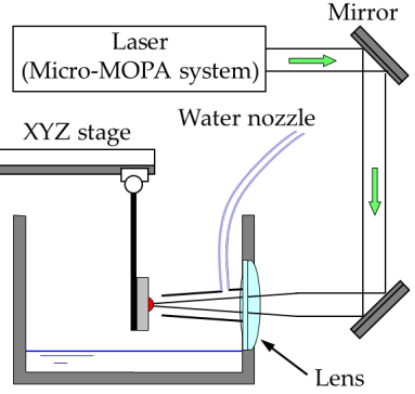
Figure 3. Schematic diagram of laser peening.